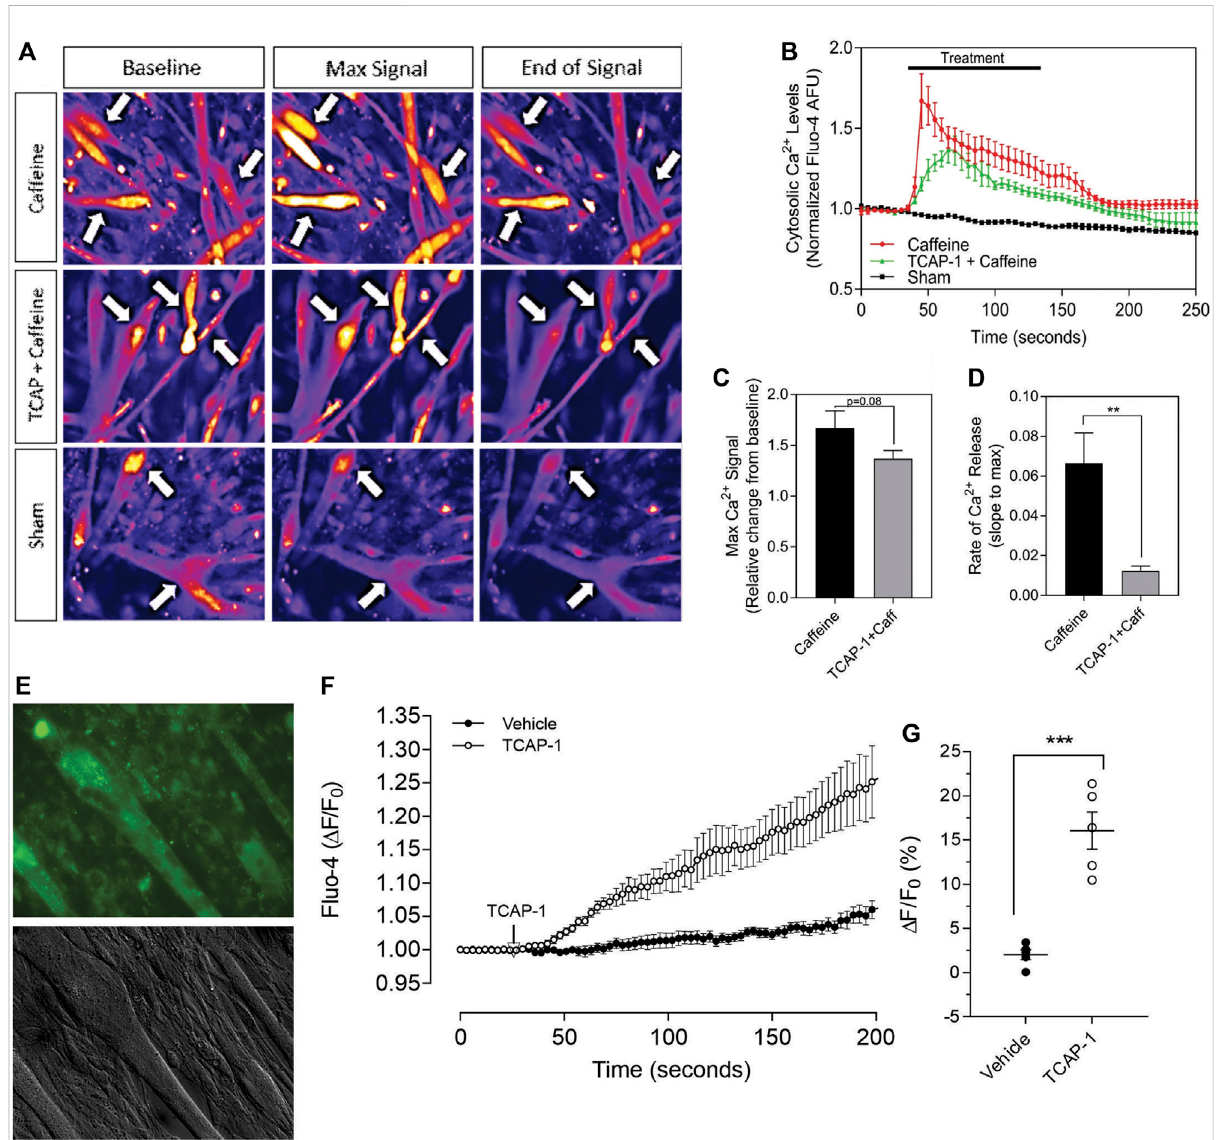
FIGURE 7 Caffeine- and TCAP-1- mediated Ca 2+ response in differentiated C2C12 myocytes. (A) . Heat-map images showing the Ca 2+ response induced bycaffeine,TCAP-1orvehicle.MeanandSEMisindicated. (B) .Dynamicconcentrationchangesovertheperiodofanalysisshownin “ A ” .Mean±SEM isindicated. (C) .Totalconcentrationchangesofthemanipulationsofthestudyperiodindicatedin “ A ” . (D) .RateofCa 2+ releasebetweencaffeineand TCAP-1. (E) . TCAP-1 mediated Ca 2+ actions show normal morphology in cells. (F) . Rate of increase in Ca 2+ -associated fl uorescence after administration of TCAP-1. (G) . Quanti fi cation of the change in TCAP-1 mediated intracellular Ca 2+ concentrations indicated in “ F ” . Signi fi cance was determined by a Students t-test. (* p < 0.05; ** p < 0.01; *** p < 0.001; **** p < 0.0001. Mean ± SEM indicated n = 4). Note that in this Figure, that F/ F0 has been set to “ 1 ” for